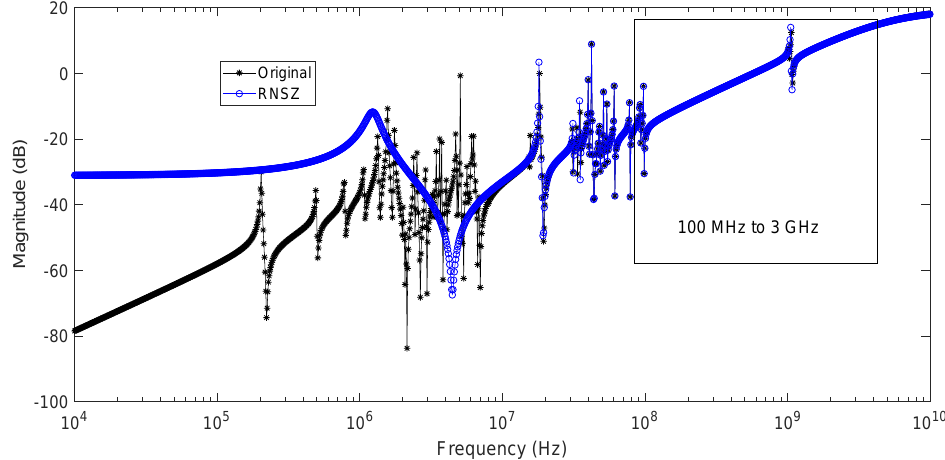
Figure 13. Original system frequency response of a spiral inductor (order n = 191) compared with a ROM generated using RNSZ of order N = 38 covering 100 MHz to 3 GHz